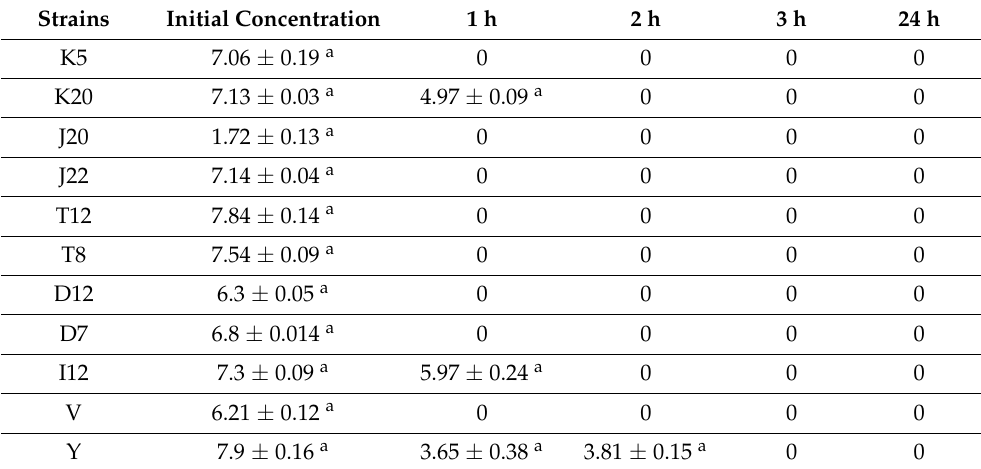
Table 3. Viability (log CFU/mL) of LAB strains incubated in phosphate buffered saline at pH 2 at 37 ◦